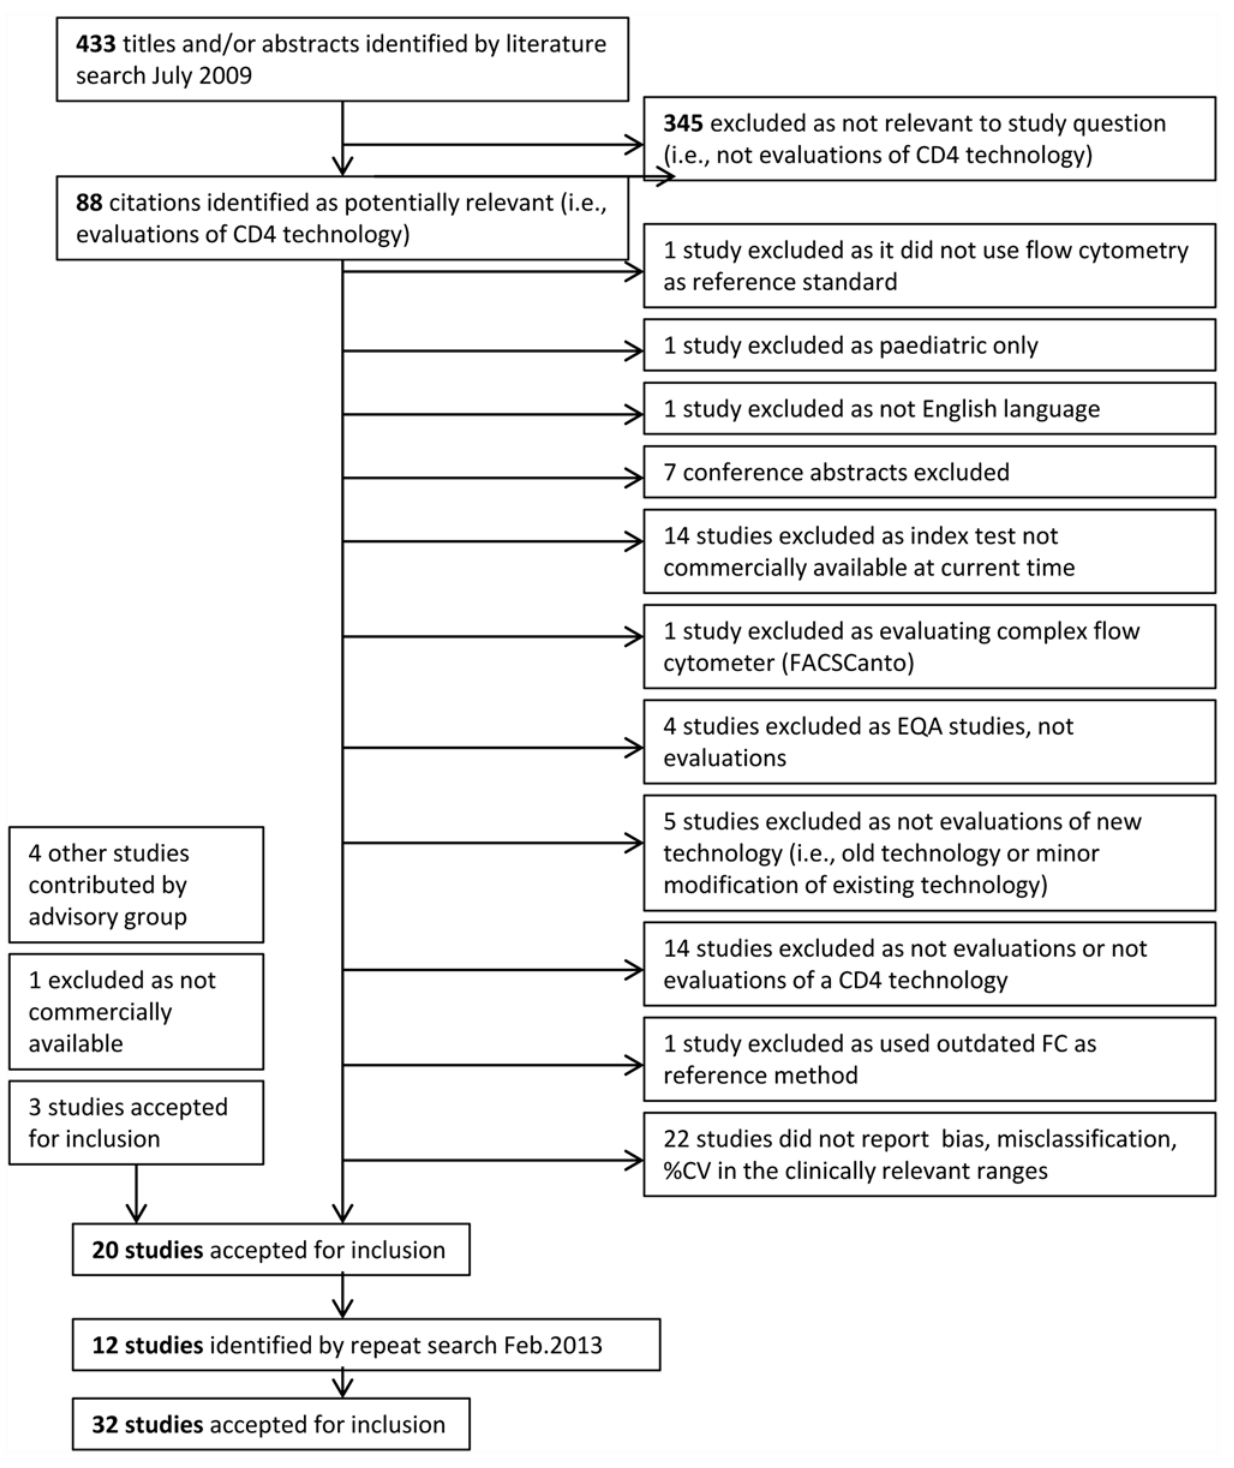
Fig 1. PRISMA flow diagram of study selection. EQA: external quality assurance, FC: flow cytometry.